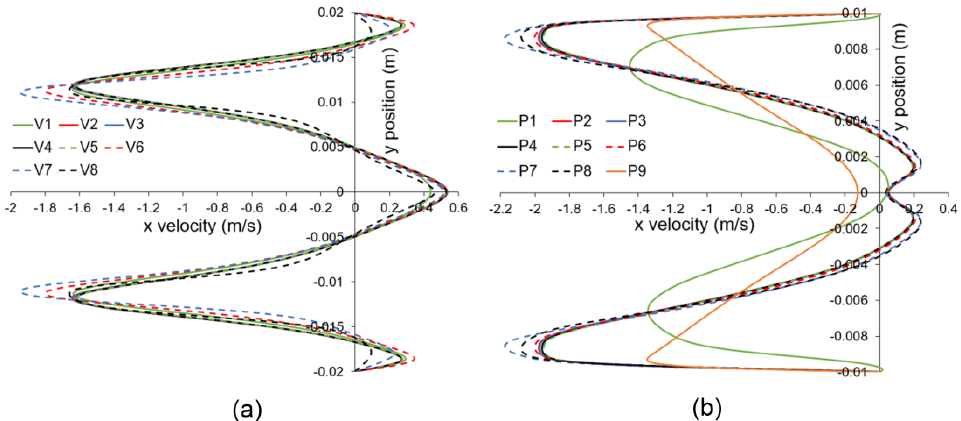
Figure 18. Distribution of x-velocities of the WCCB15 configuration for CVGs position ‘5’ for Re = 1677 ( Q = 10 m 3 /h), ( a ) sections of the 1st to 8th valley, ( b ) sections of the 1st to 9th peak. New correlating equations for the mean Nusselt number Nu m were created for the WCCA and WCCB configurations and CVGs position of ‘1’ to ‘5’ for the flow rate Q in the range of 10 m 3 /h to 50 m 3 /h, CVGs diameter of D = 10 mm and 15 mm, and the channel height H = 40 mm.